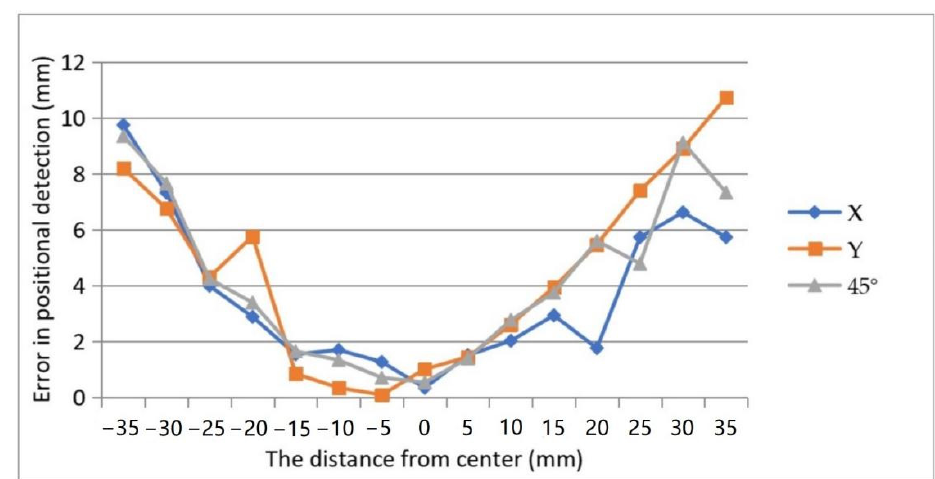
Figure 10. Errors in positional detection by experiment.